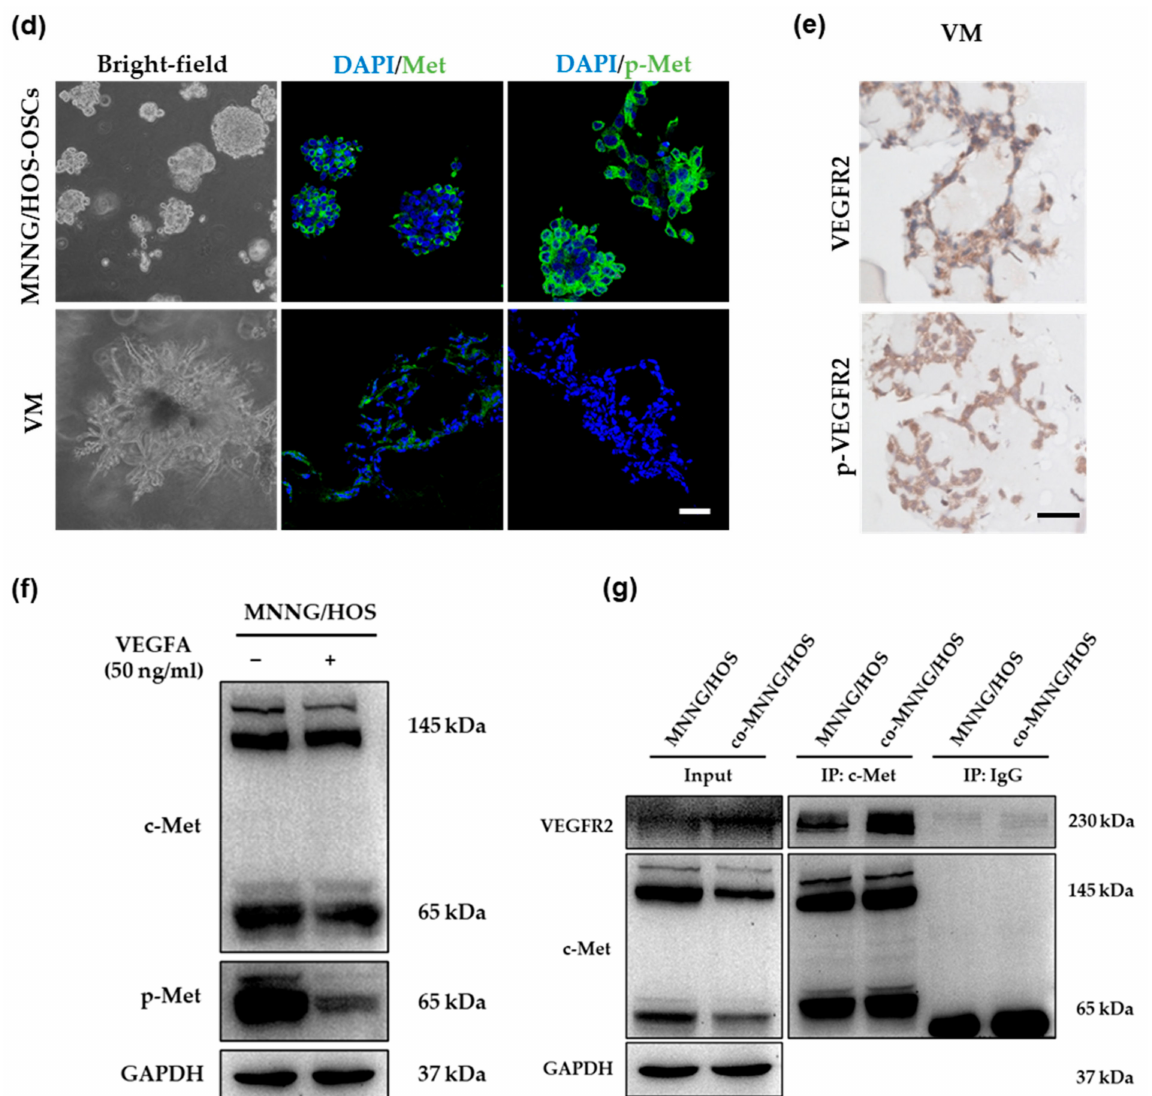
Figure 5. VEGFR2 activation might tie up with the downregulation of c-Met signaling in MNNG/HOS cells. ( a – c ) qRT-PCR ( a , b ) and Western blotting ( c ) analysis on the expression and phosphorylation of c-Met and VEGFR2 in MNNG/HOS cells and co-MNNG/HOS cells after being treated with 0.05 µ M PF02341066 for 48 h. Mean ± SEM, three independent experiments, n = 3. *** p < 0.001, * p < 0.05 two-tailed Student’s t -test. ( d ) Immunofluorescence staining of MNNG/HOS- OSCs and VM revealed c-Met and the phosphorylation of c-Met. Scale bar = 50 µ m. ( e ) IHC analysis on the activation of VEGFR2 in VM. Scale bar = 50 µ m. ( f ) Western blotting analysis on the expression and the phosphorylation of c-Met in MNNG/HOS cells after 50 ng/mL VEGFA induction for 72 h. ( g ) Representative images of immunoprecipitation revealed a physical interaction between c-Met and VEGFR2. Detailed information about Western blot can be found at supplementary